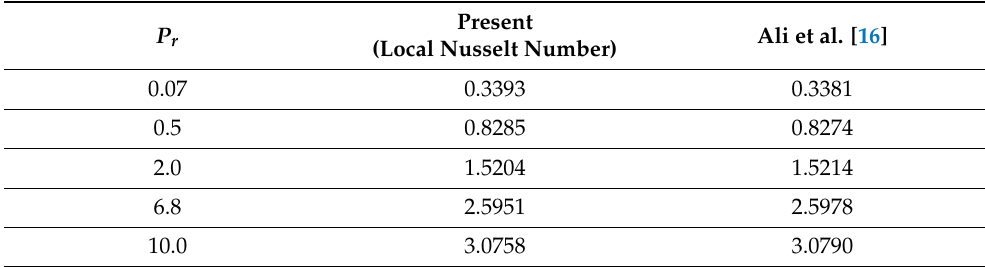
Table 4. The Local Nusselt number for various P r when p = 1.0, λ = N = 0.0, γ = 1.0, δ = 3.0, ξ = 0.0 , β =